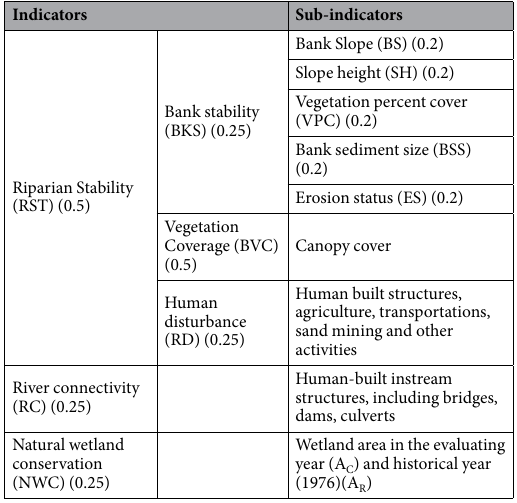
Table 3. The field-based indicators and weights of